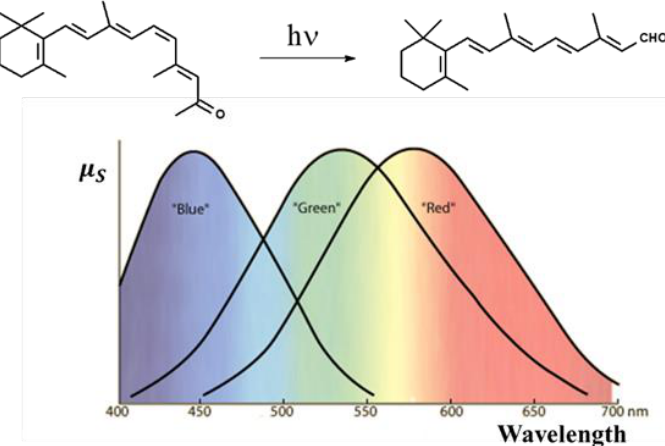
Figure 4. Absorption spectra of the cones (“Blue”, “Green”, and “Red”) that partition the spectral region of visible light in three Fuzzy sets. The chromophore responsible for the bands is always the retinal that photo-isomerizes from 11- cis to all- trans configuration after absorption of a photon having the right frequency.